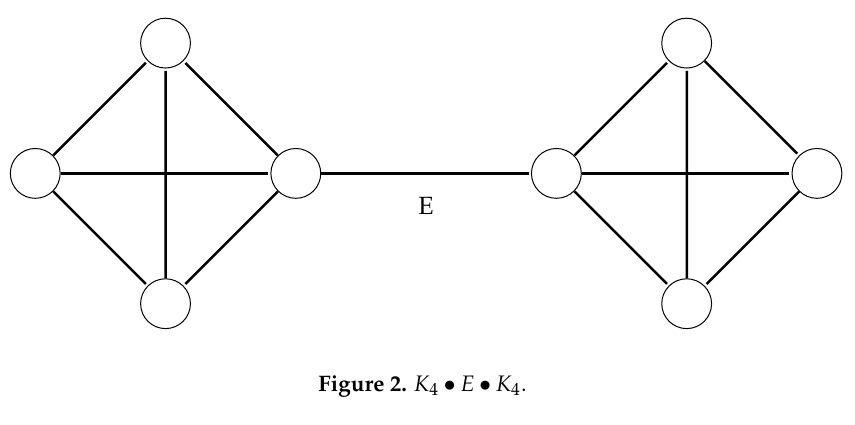
Figure 2. K 4 • E • K 4